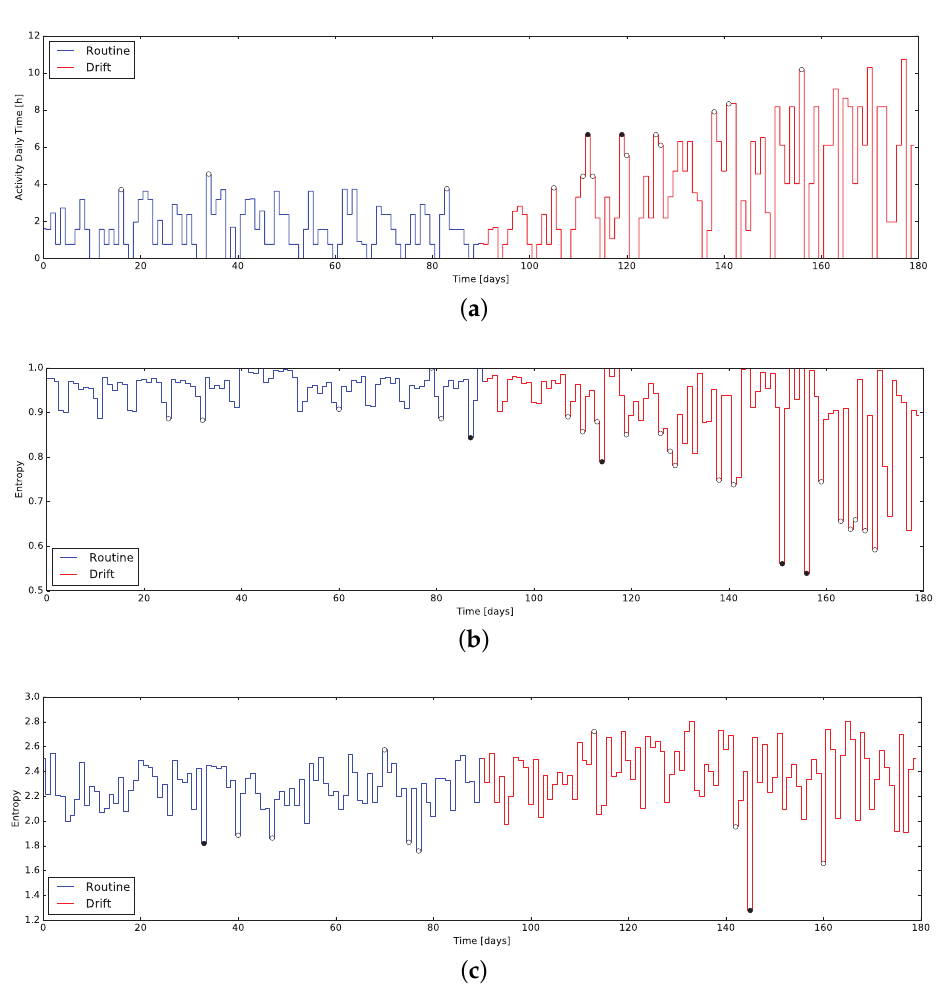
Figure 8. Results of the σ Q -test on ( a ) Activity Daily Time (ADT) for “watching TV”; ( b ) Entropy Based (EB) for the bed sensor; and ( c ) EB for the whole house. The unexpected events are flagged with circles: white markers represent warnings , while black alarms . It is evident how abrupt changes are flagged correctly with markers, which tend to be more frequent after the induced change in routine, while the behavioral drift